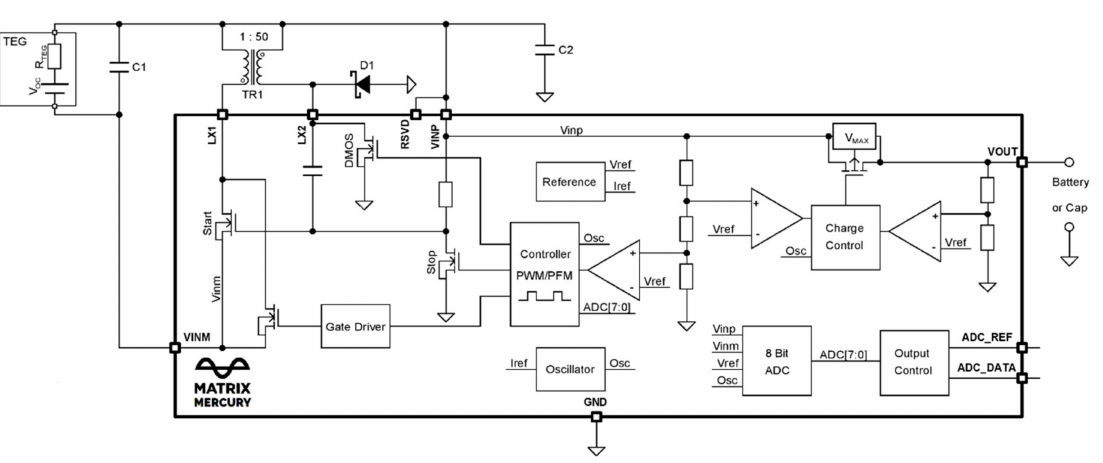
Figure 1. Block diagram of Matrix Mercury